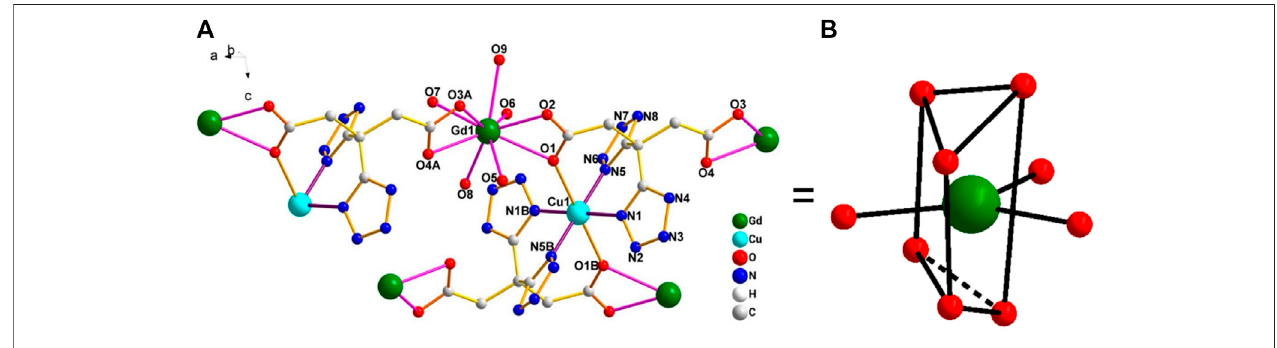
FIGURE 2 | (A) Diagram of the coordination environment of the Gd(III) and Cu(II) center in the complex [Gd 2 Cu(L) 2 (H 2 O) 10 ] · 6H 2 O. (B) Distorted tricapped trigonal prism of Gd(III).